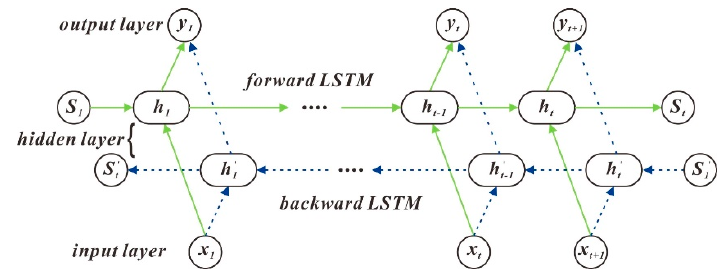
Figure 9. Bi LSTM algorithm structure diagram.